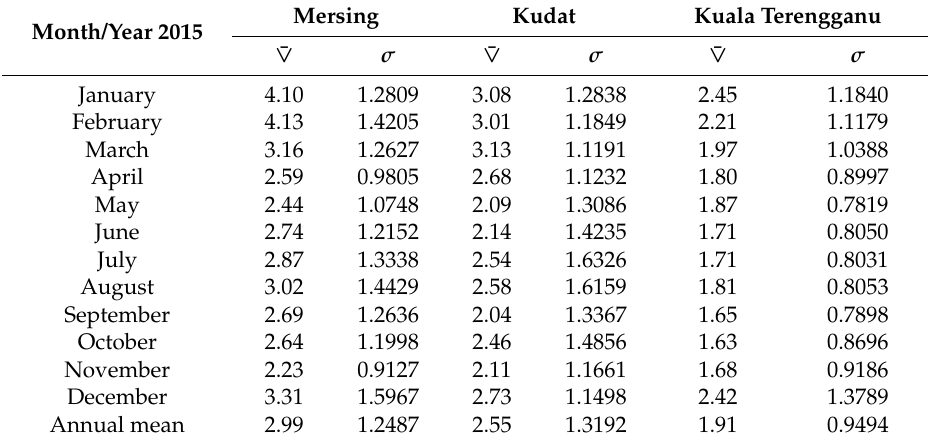
Table 2. Monthly mean wind speed and standard deviation of three sites in